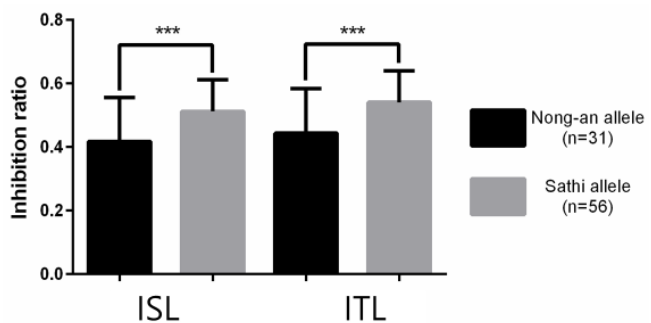
Figure 5. Comparison of inhibition ratio between ‘Nong-an’ and ‘Sathi’ alleles on SNP markers C08-70 and C08-71 for ISL (inhibition rate of shoot length) and ITL (inhibition rate of total length). Significance was determined by t -test. *** Indicates significance in 0.001 probability level.